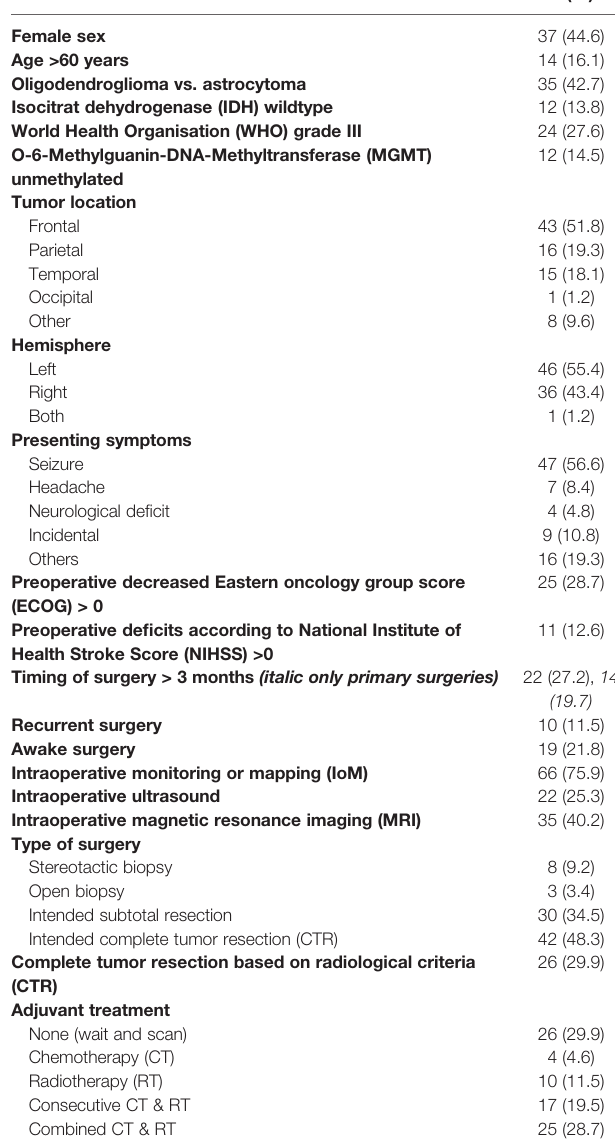
TABLE 1 | Patients´ and treatment characteristics.